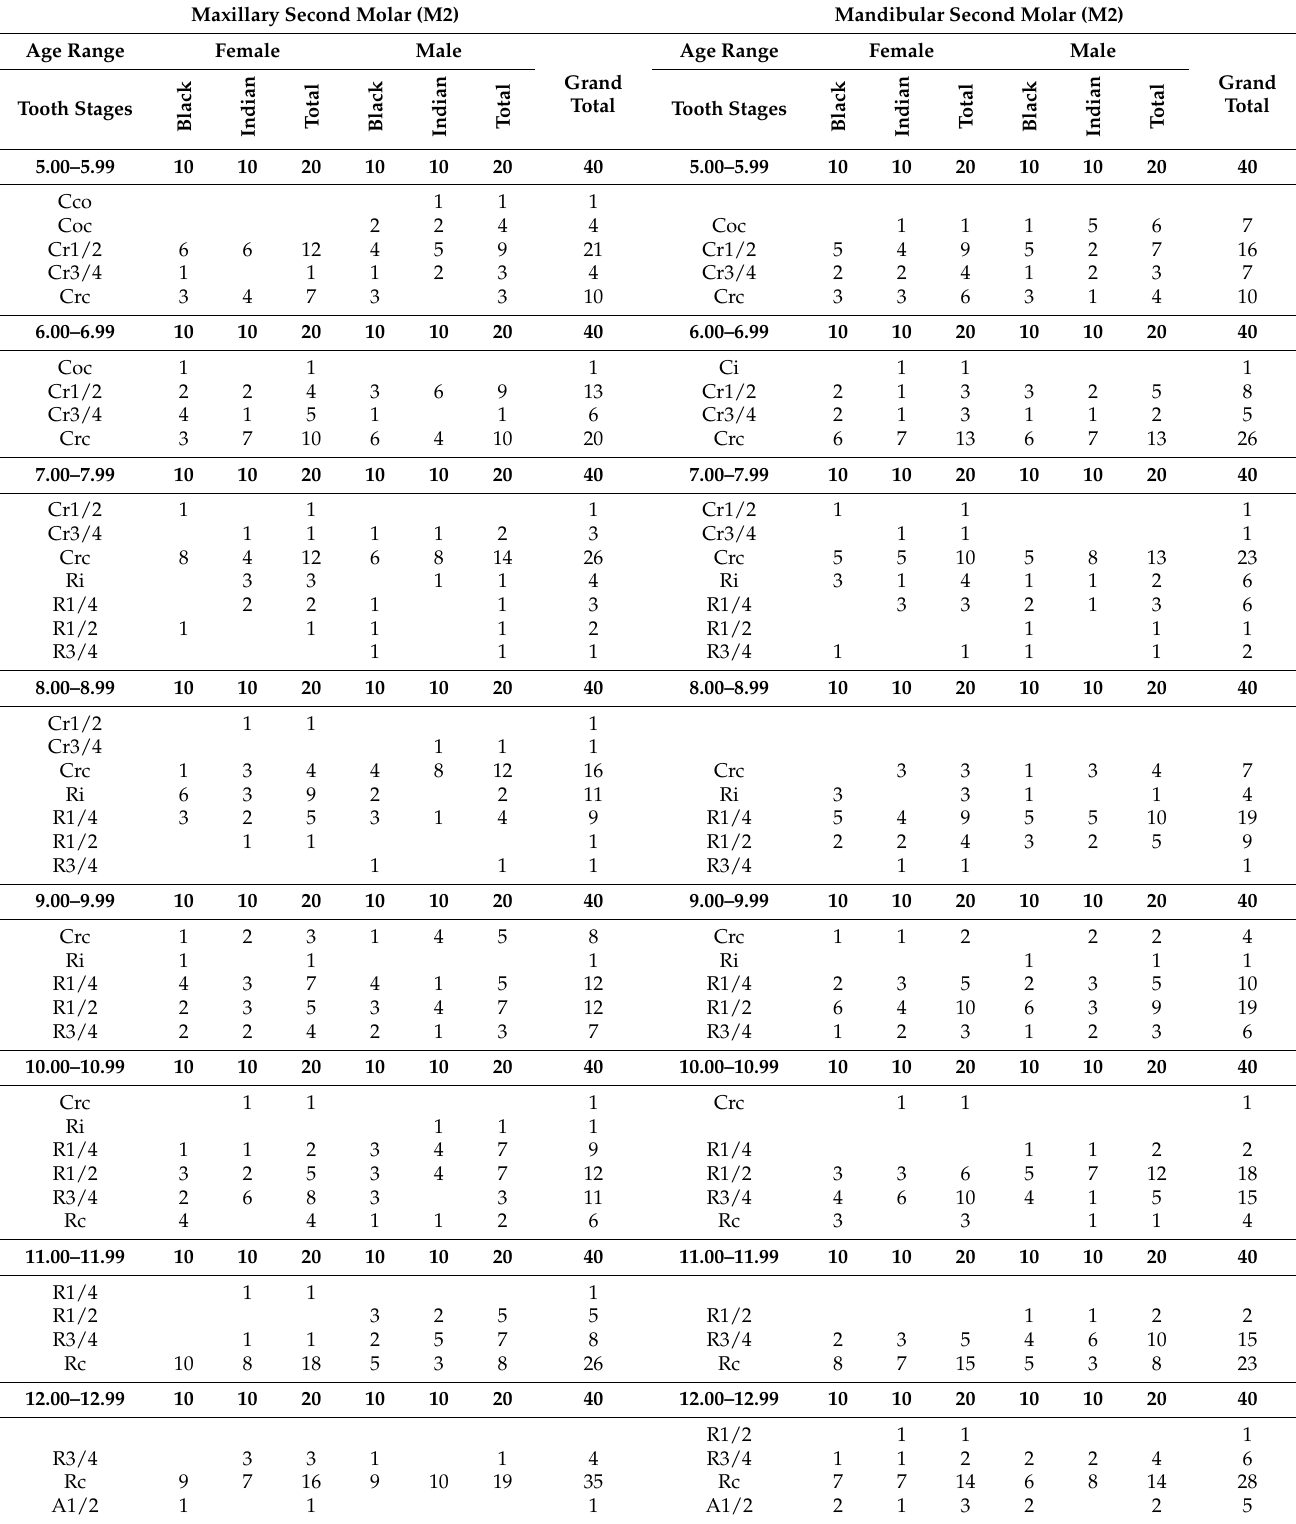
Table A7. Frequencies of the tooth development stages of the second molar for the SA Black and Indian population